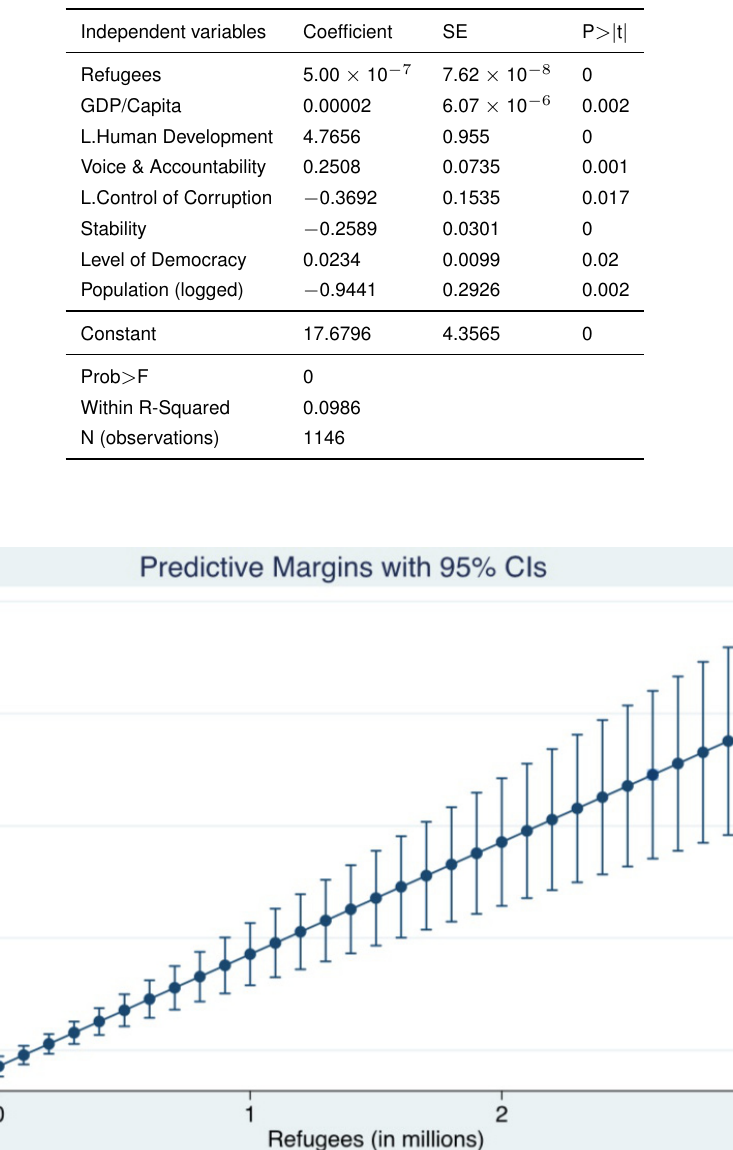
Table 1. Refugees and violent group grievance Driscoll-Kraay (DV) XT regression with fixed effects.